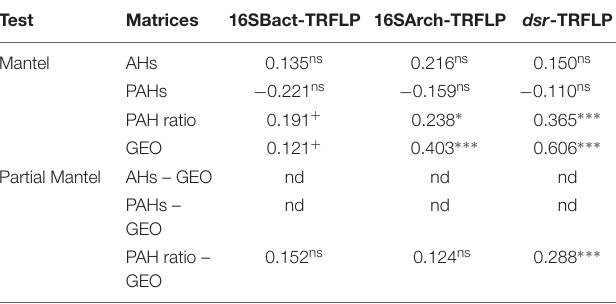
TABLE 3 | Spearman correlation coefficients ( R ) of Mantel and partial Mantel tests between the distance matrices of pollutant descriptors (Euclidean distance), geographical locations (Euclidean distance), and community structures (Bray-Curtis) of Bacteria (16SBact-TRFLP), Archaea (16SArch-TRFLP), and SRB (dsr-TRFLP) based of T-RFLP profiles.